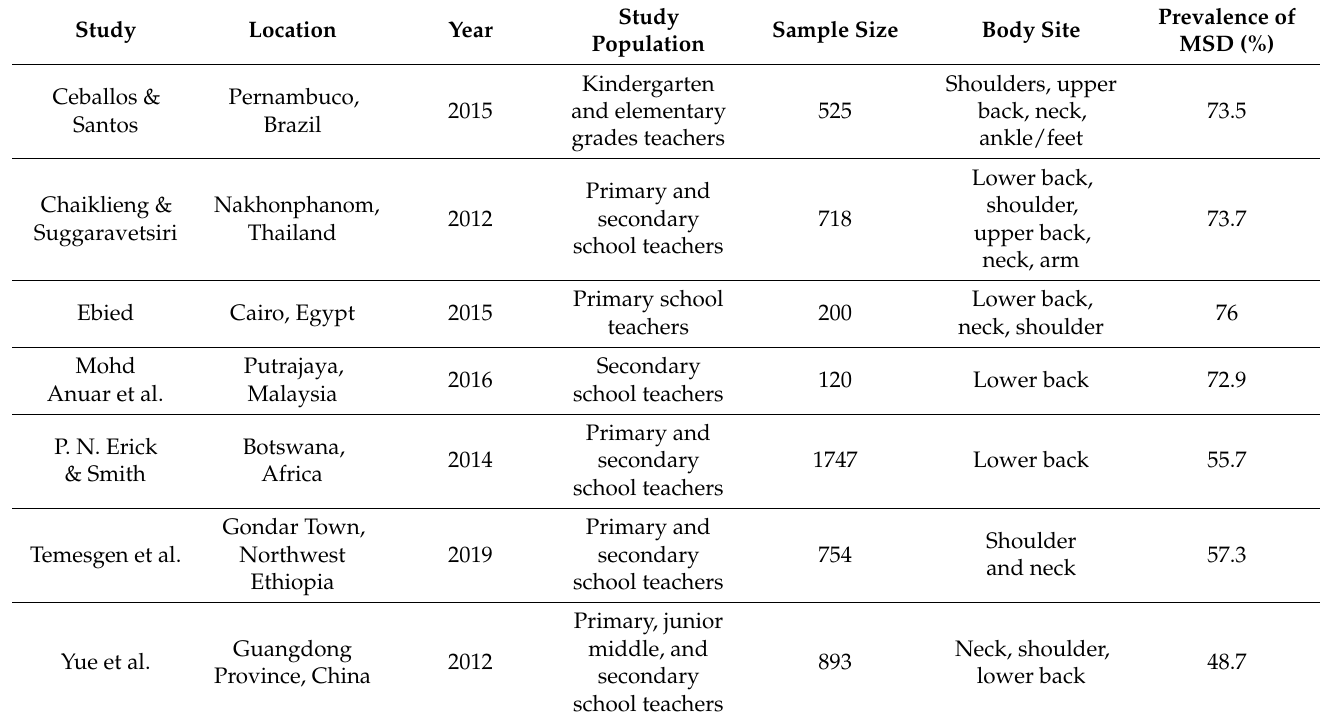
Table 1. Studies reporting the prevalence of MSD among regular school